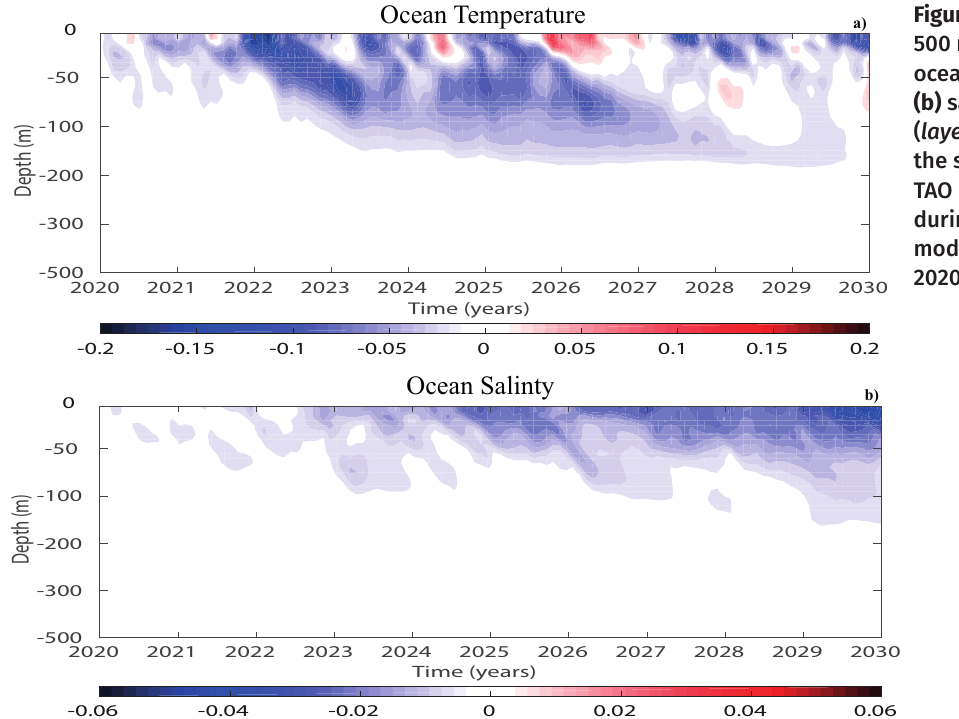
Figure 4. Time x depth (0– 500 m) mean profile of (a) ocean temperature and (b) salinity